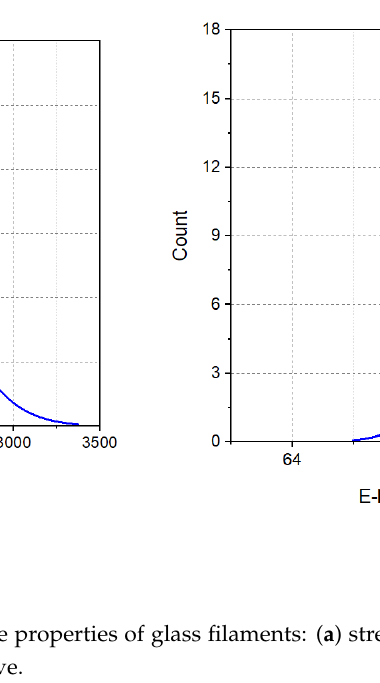
Figure 8. Tensile properties of glass filaments: ( a ) strength distribution curve and ( b ) E-modulus distribution curve.